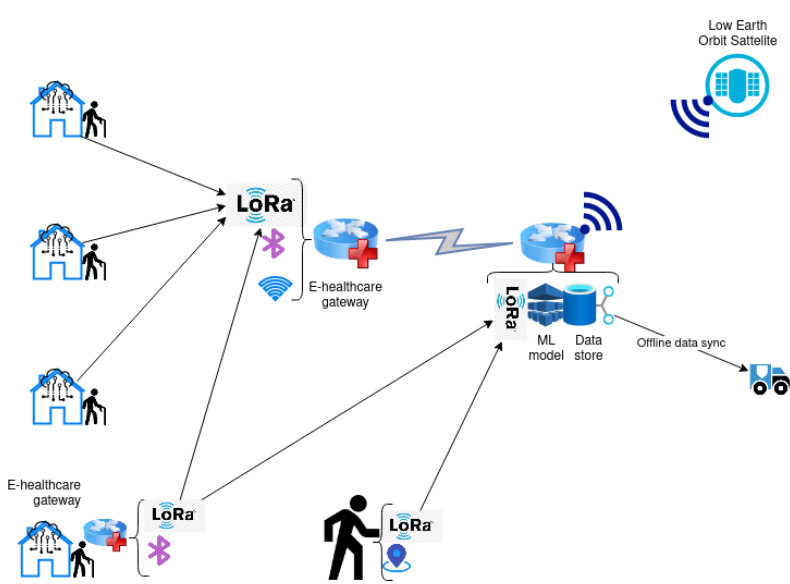
Figure 1. System architecture for rural area network for healthcare IoT.